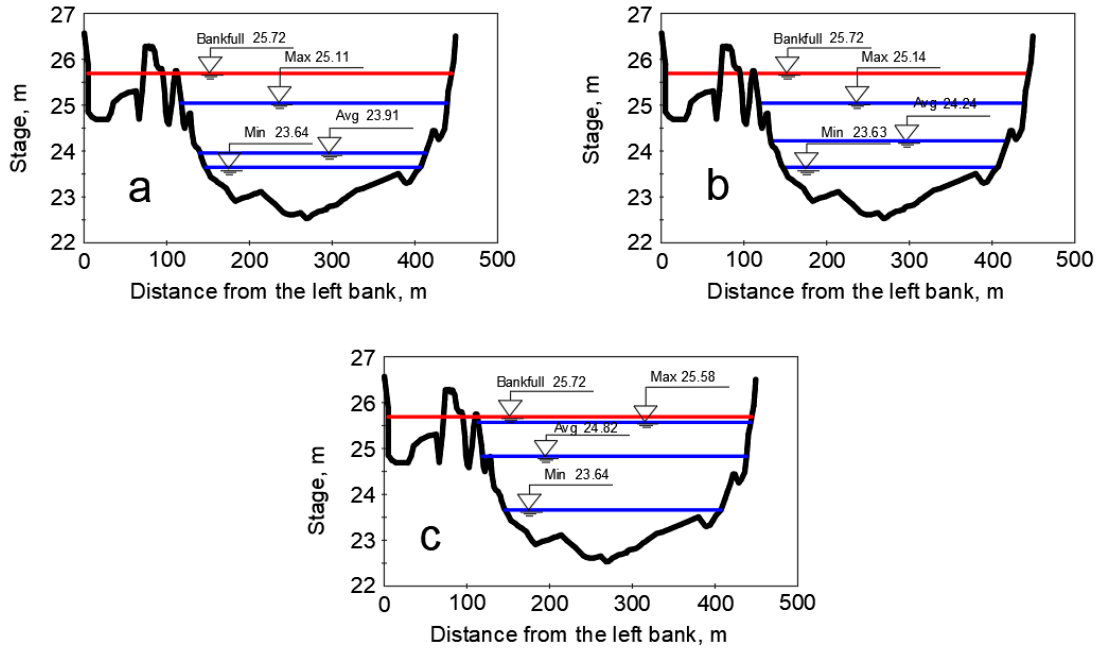
Figure 4. Three river channel situations showing range of stored water in terms of stage during investigated period (Kaunas HPP GS): ( a ) dry year (2015), low river channel water storage; ( b ) average year (2016), moderate river channel water storage; ( c ) wet year (1988), high river channel water storage (red line—bankfull water storage level, blue lines—maximum, average and minimum water storage levels).